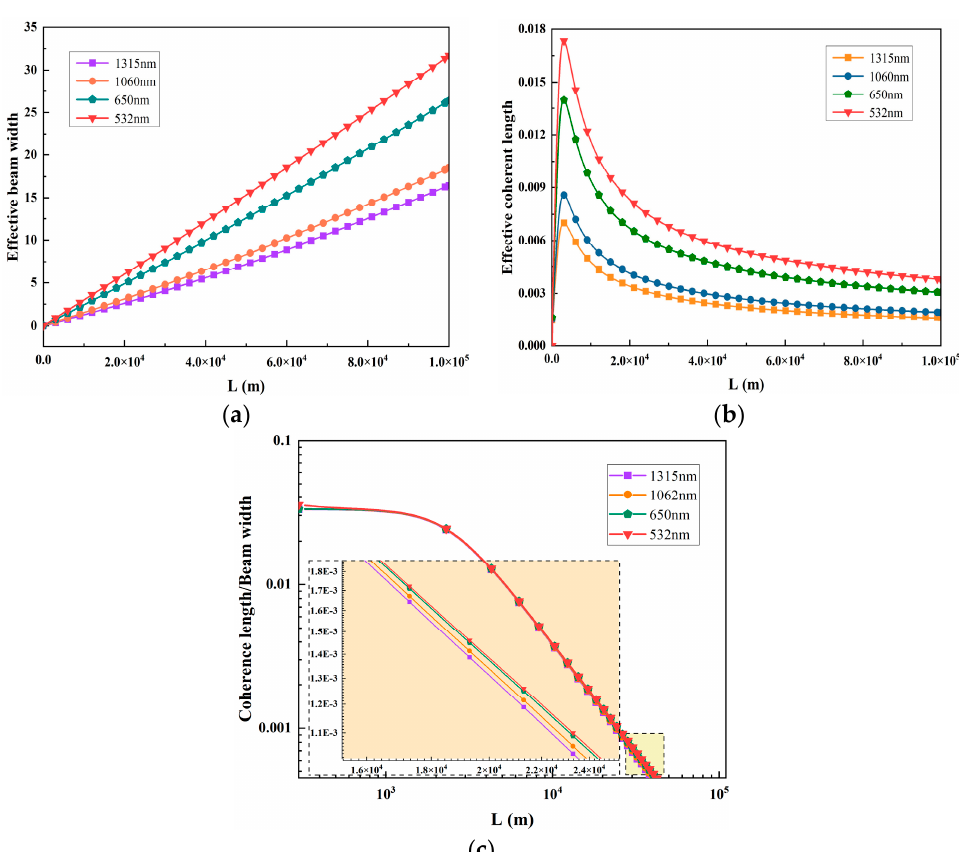
Figure 9. The impact of beam wavelength on the beam width ( a ) and coherence length ( b ) and their ratio ( c ) in turbulent conditions.